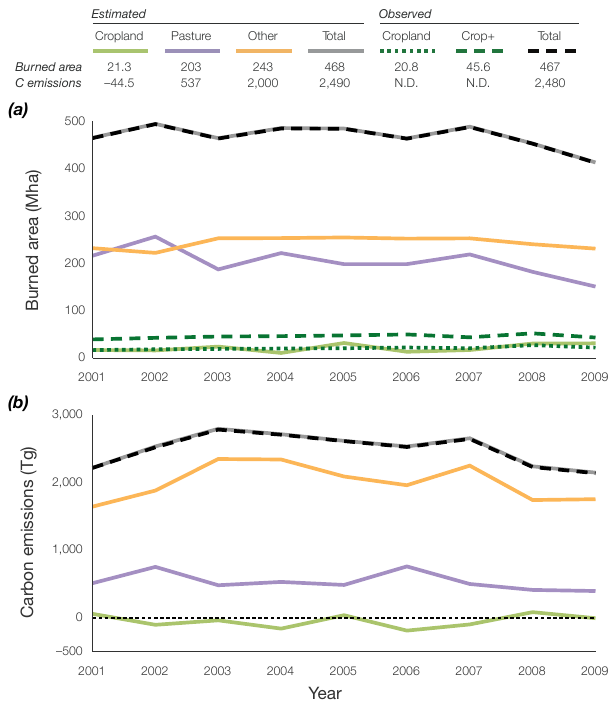
Figure 2. Observed and estimated annual time series of net ob- served and estimated global burned area ( a ; Mha) and C emissions ( b ; Tg = Mt). Numbers in table represent annual means. “N.D.”: no data; “Crop+”: cropland + cropland–natural mosaic. Corresponds to Fig.